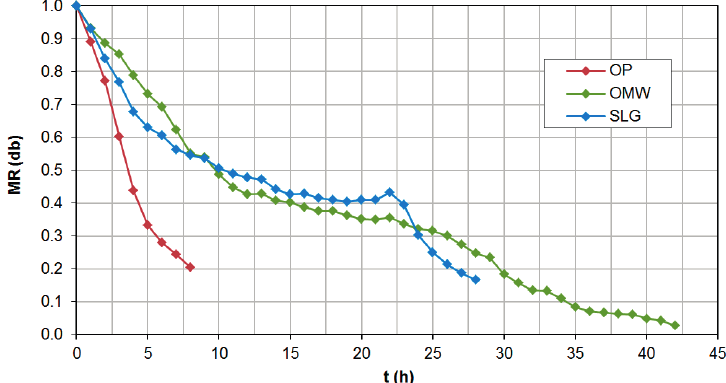
Figure 4. MR (db) mixed passive